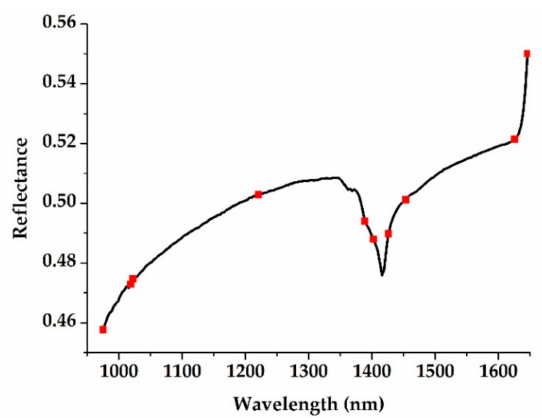
Figure 5. The characteristic wavelengths (square markers) selected using